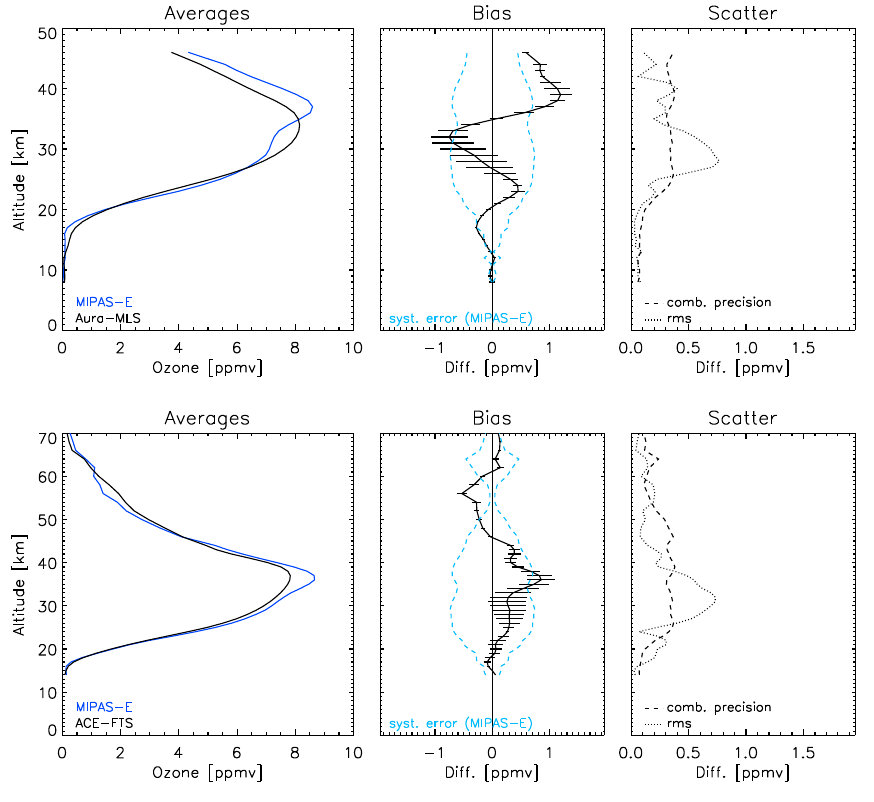
Fig. 18. Same as Fig. 2, but for Aura/MLS (top row) and ACE-FTS (bottom row) ozone profiles. For a more detailed description see Fig. 2.